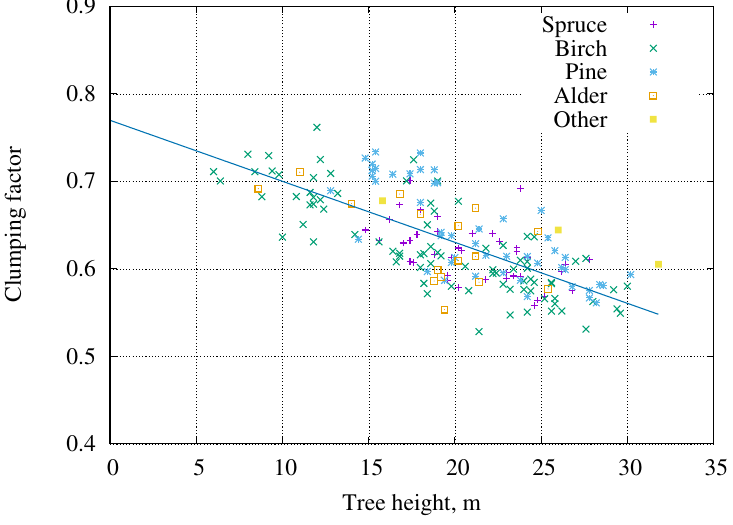
Figure 8. Tree height and clumping factor.